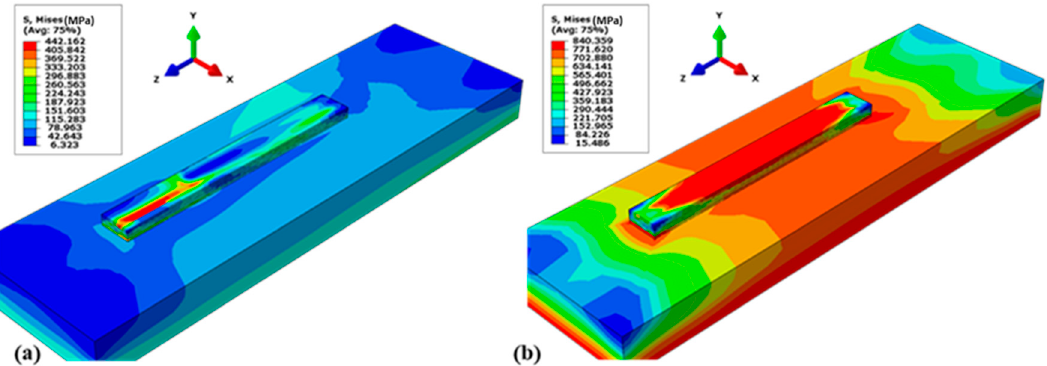
Figure 14. ( a ) Von Mises stress during deposition at t = 9.125 s, layer-4. ( b ) Von Mises stress after final cooling.